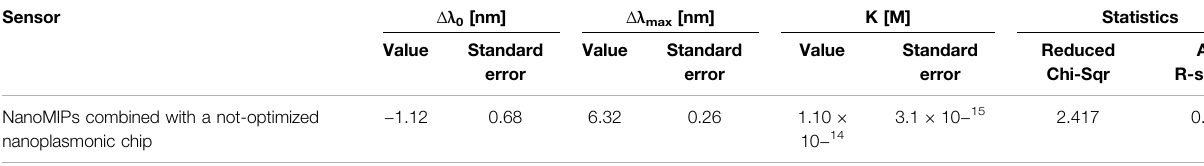
TABLE 1 | Langmuir parameters of BSA detection in buffer solution exploiting the proposed biochemical sensor. Sensor